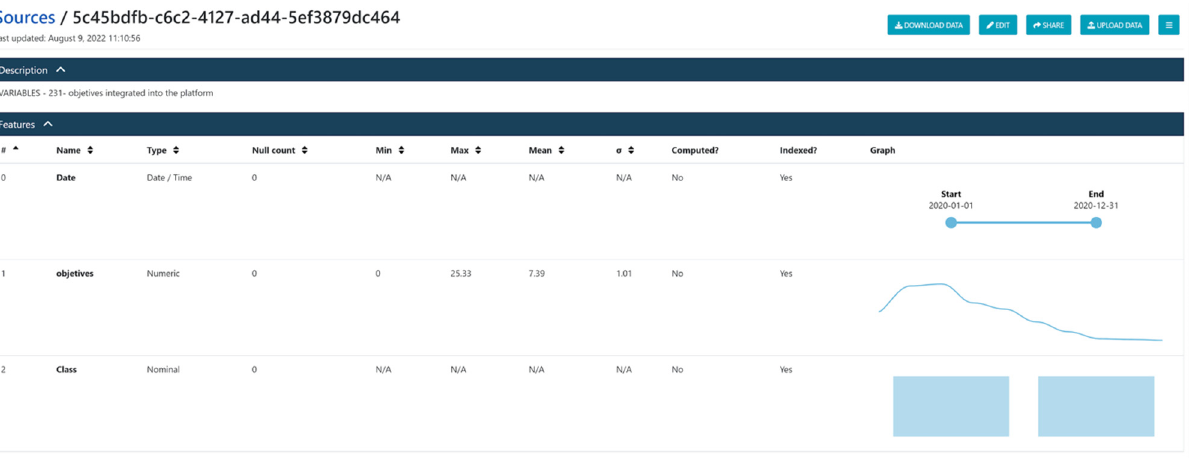
Figure 2. Objectives integrated into the platform.